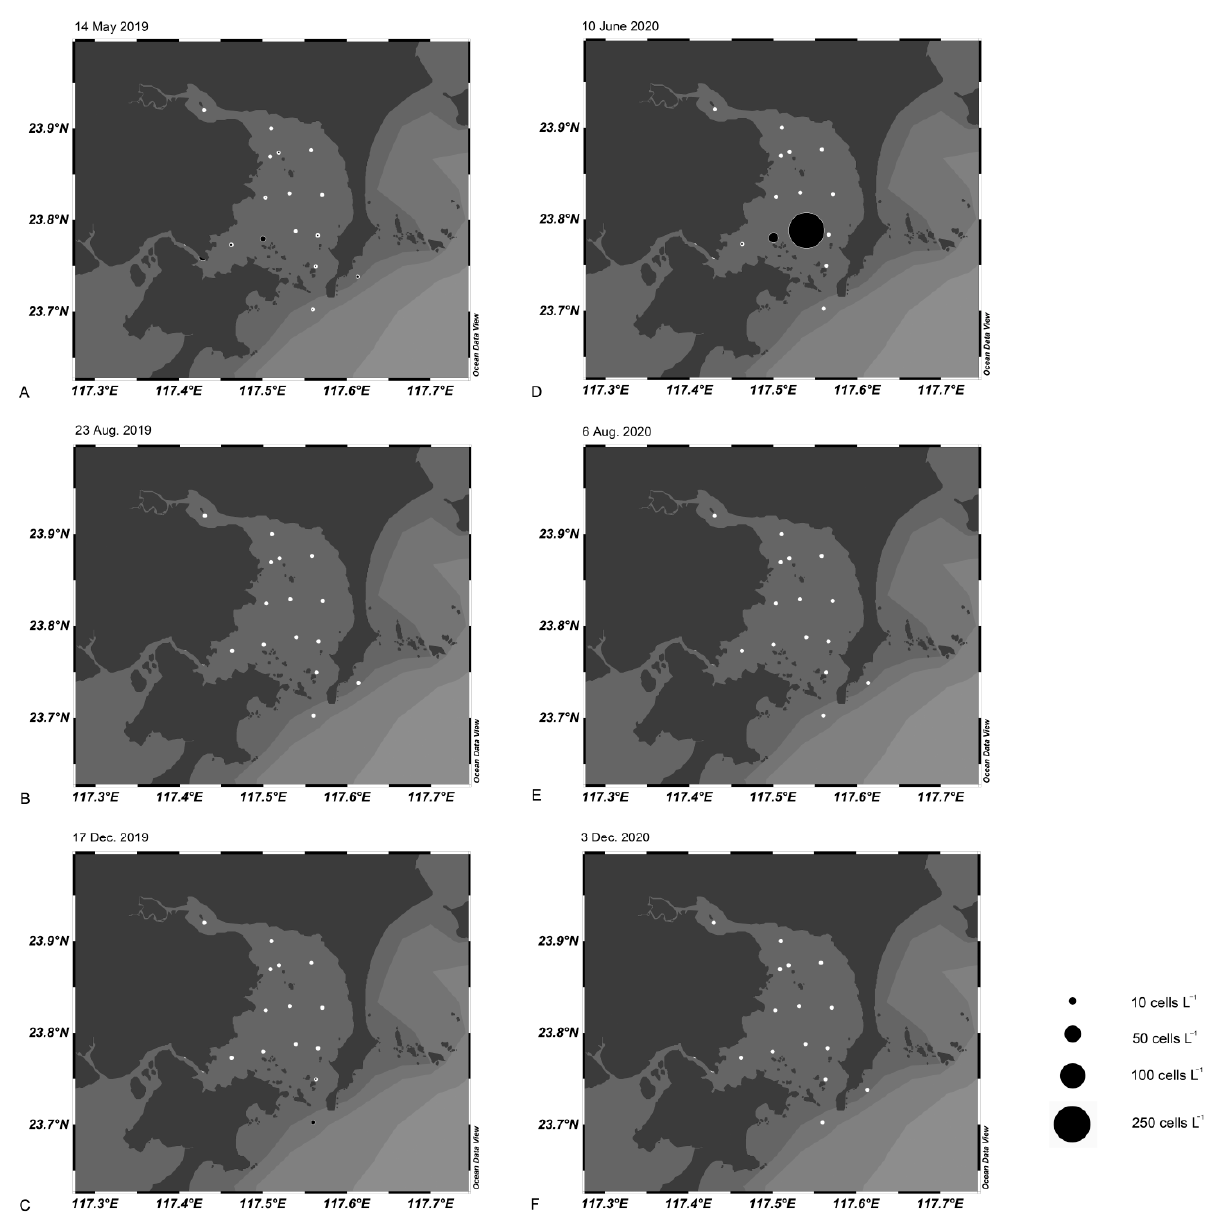
Figure 5. Cell abundance (cells L − 1 ) of Alexandrium pacificum determined by qPCR in water samples from Dongshan Bay in May 2019 ( A ), August 2019 ( B ), December 2019 ( C ), June 2020 ( D ), August 2020 ( E ), and December 2020 ( F ). White dots represent collection sites where no cells were detected.